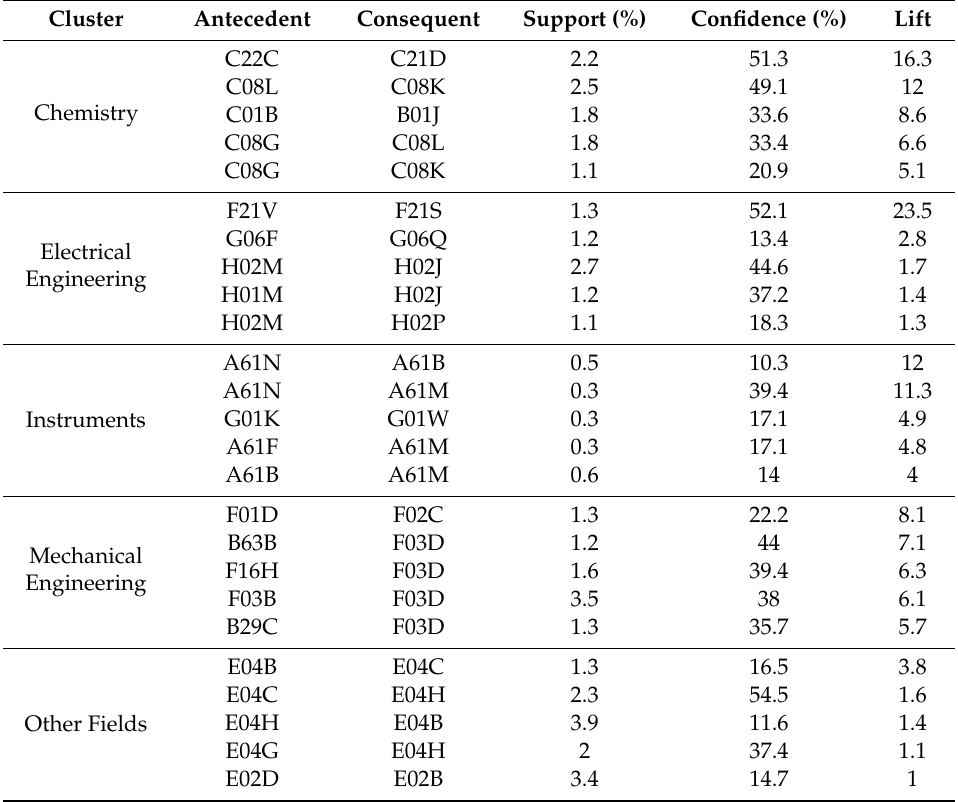
Table 7. Examples of association rules between IPC codes and their support, confidence, and